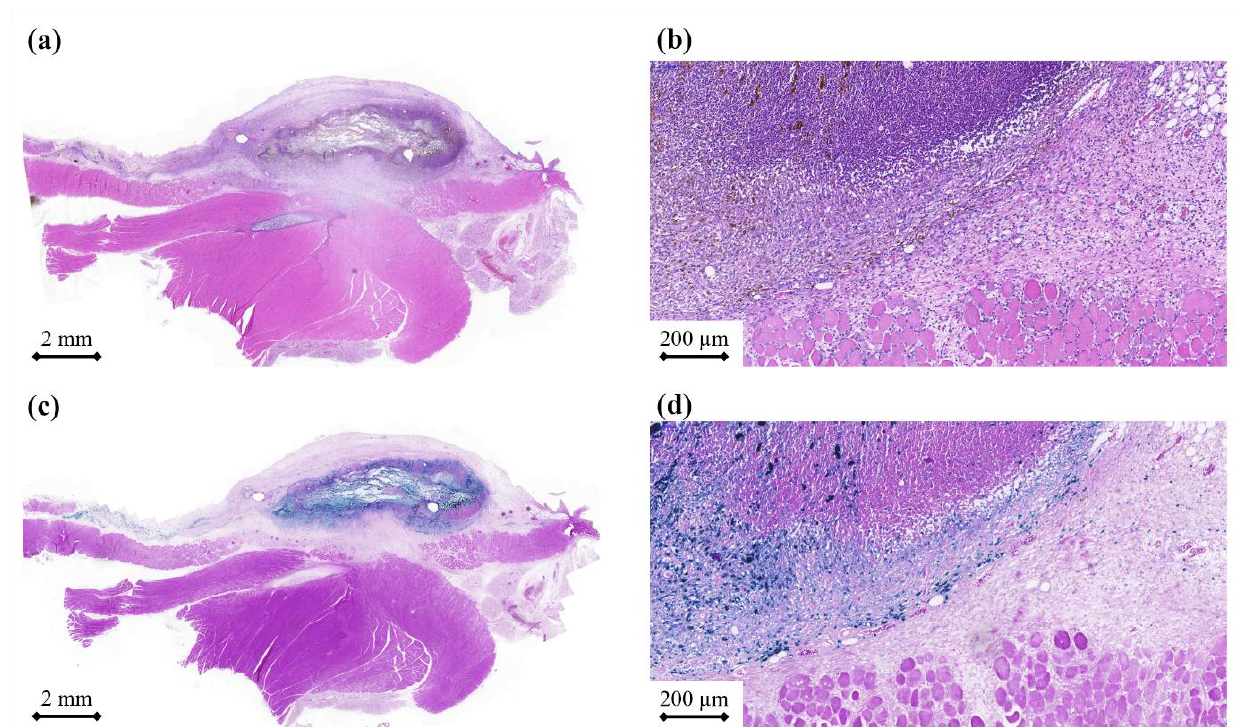
Figure 4. ( a , b ) Sample stained with haematoxylin and eosin at 10 × and 100 × magnifications, respectively. There was a sharp demarcation between the fibrous structure of the PSI sample and the dorsal muscles of the animal. ( c , d ) Sample stained with Berlin Blue at 10 × and 100 × magnifications, respectively. The iron content of the of the sample is seen in blue.